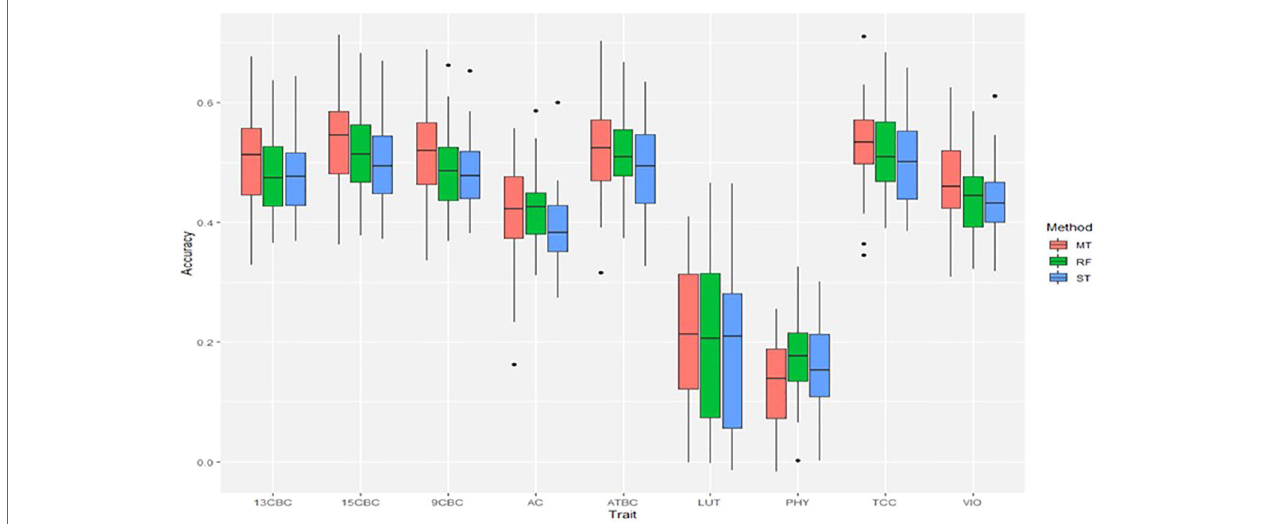
FIGURe 3 | Genomic predictions for total carotenoid content (TCC), all-trans β-carotene (ATBC), violaxanthin (VIO), lutein (LUT), 15-cis beta-carotene (15CBC), 13-cis beta-carotene (13CBC), alpha-carotene (AC), 9-cis beta-carotene (9CBC), and phytoene (PHY) cassava root carotenoids. For each trait: ST = single trait GBLUP, RF = single trait random forest and MT = multiple-trait GBLUP models.